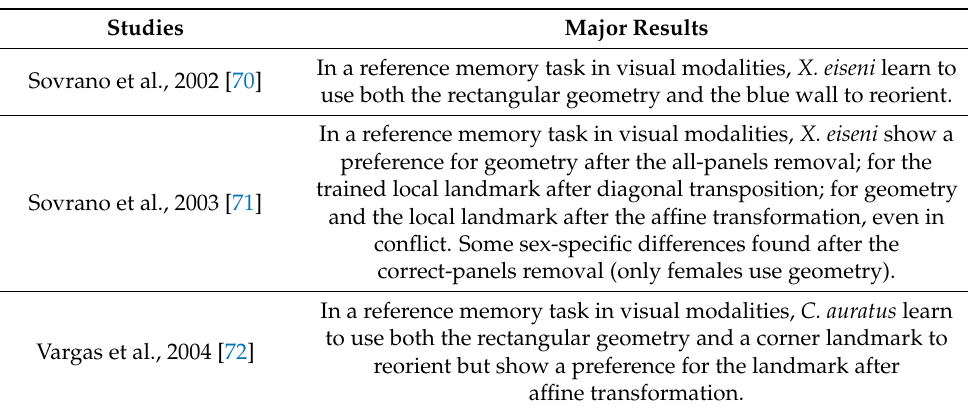
Table 1. Summary of major findings on geometric navigation by fishes, within visual and nonvisual spatial layouts. Working and reference memory tasks are specified to distinguish across behavioral protocols, visual and nonvisual to distinguish across experimental modalities.